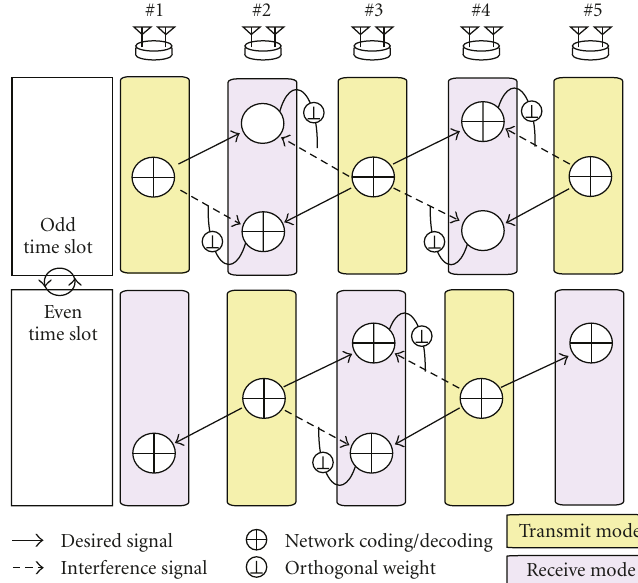
Figure 4: MIMO network coding